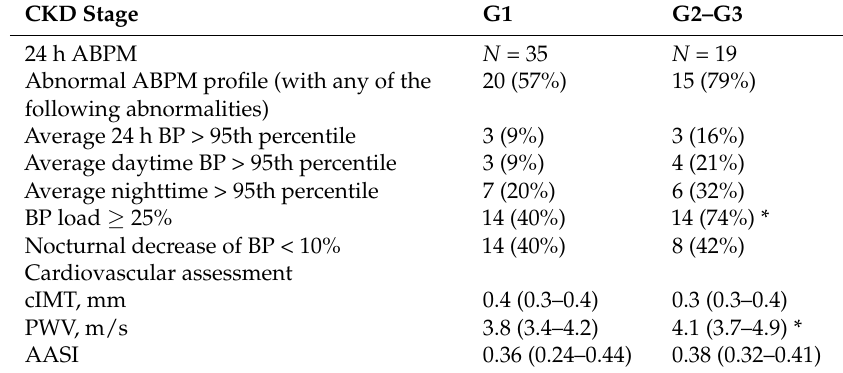
Table 2. ABPM profile and cardiovascular assessment in children with CKD stage